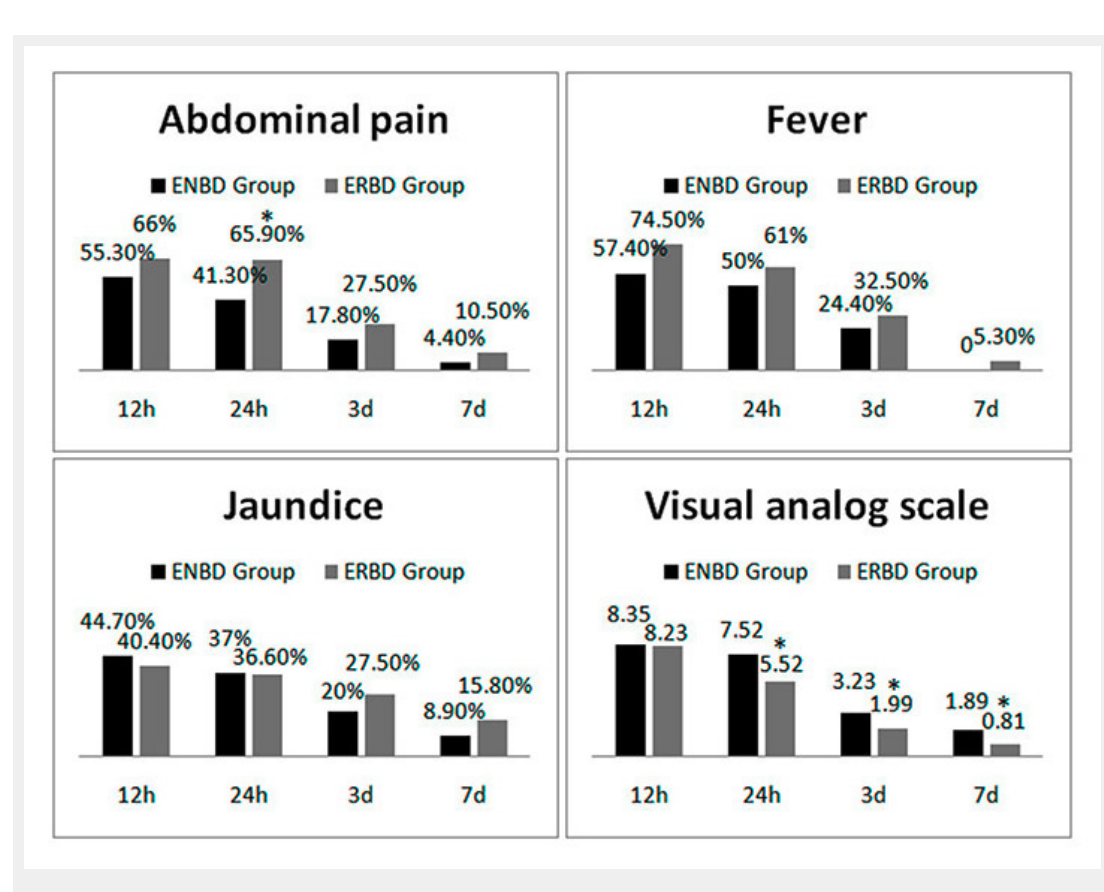
Figure 1 Rates of abdominal pain, fever and jaundice 12 hours, 24 hours, 3 days and 7 days after endoscopic retrograde cholangiopancreatography in the endoscopic nasobiliary drainage (ENBD) and endoscopic retrobiliary drainage (ERBD) groups. * p <0.05 vs ENBD